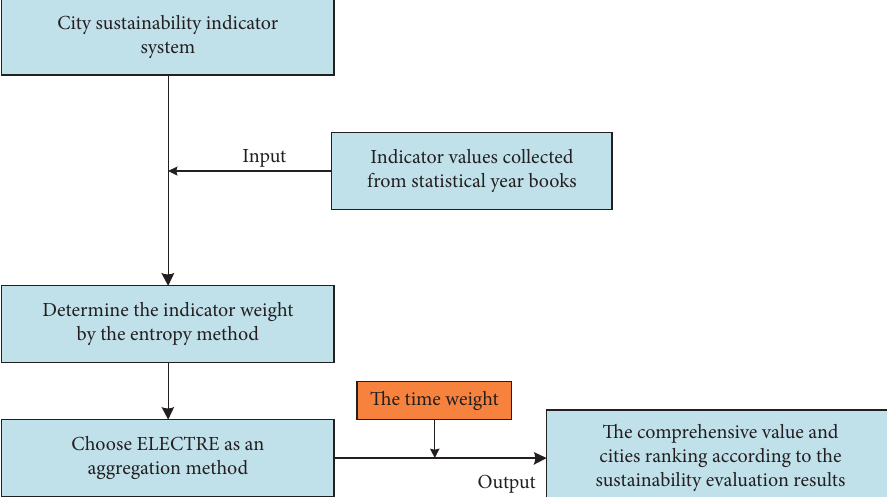
Figure 1: Urban sustainability evaluation processes.